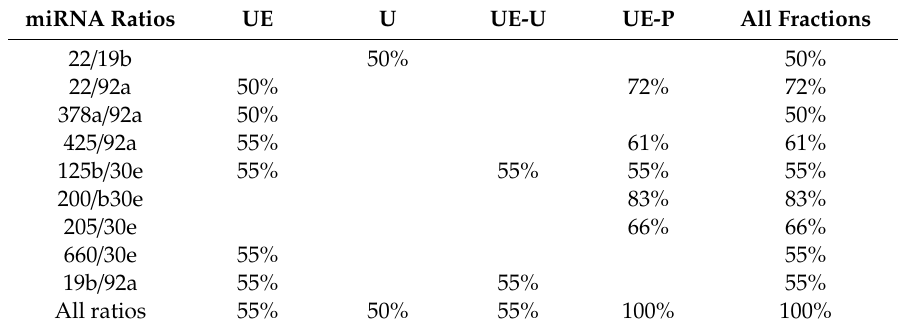
Table 9. Definitely ill. The percentage of PCa and BPH patients divided from the control group (HD). miRNA